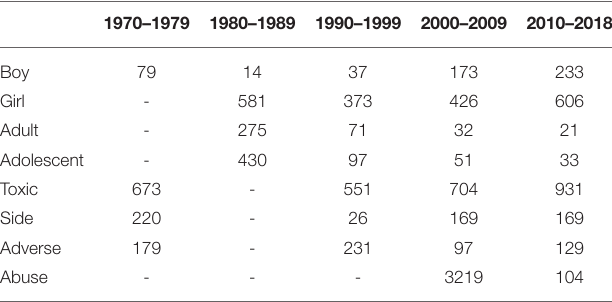
TABLE 2 | Word ranking by decade on methylphenidate